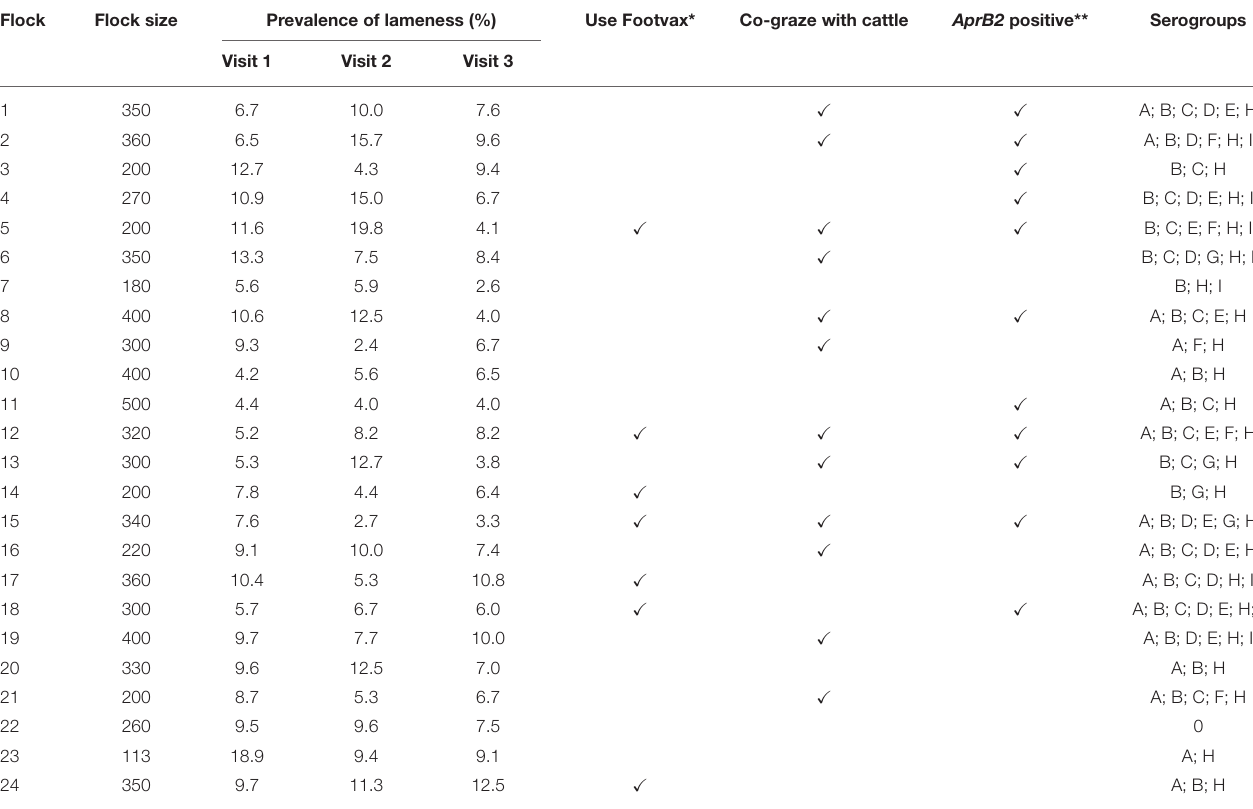
TABLE 2 | Summary information on 24 flocks with clinical footrot: flock size, prevalence of lameness by visit, use of Footvax, co-grazing with cattle, detection of D. nodosus variant aprB2 and detection of serogroups of D. nodosus . Flock Flock